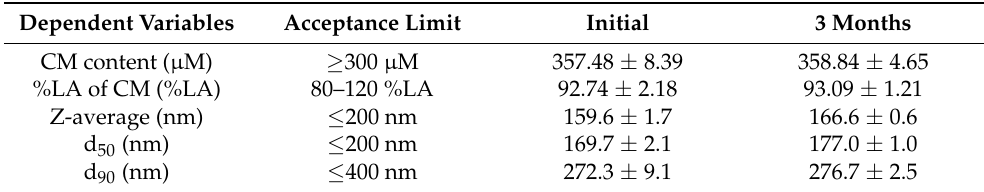
5 ◦ C for 3 months (Mean ± SD, n =